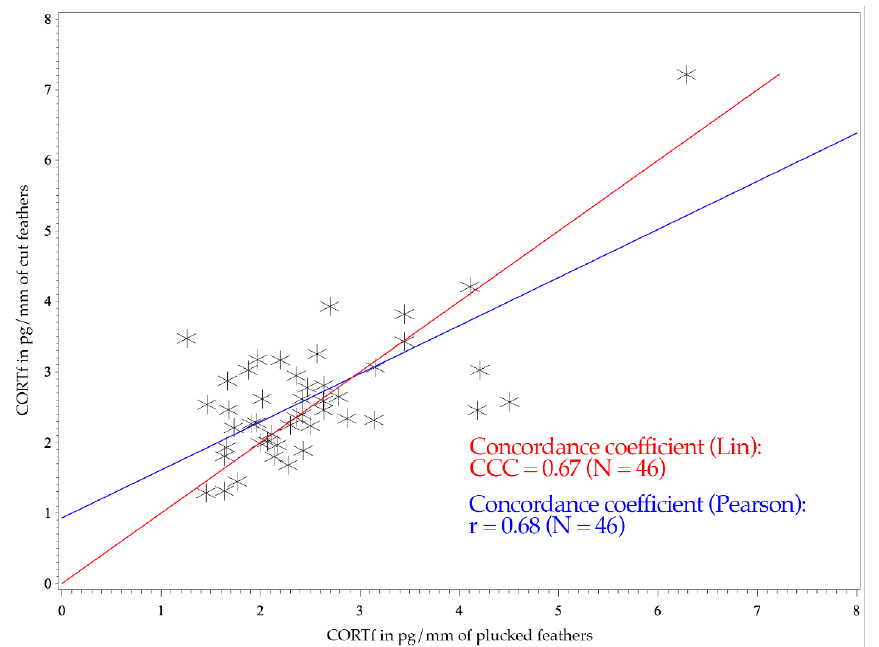
Figure 1. CCC and Pearson’s concordance coefficients of 46 Mallards ( Anas platyrhynchos ). The x - axis shows the CORTf values of plucked feathers in pg/mm, and the y -axis represents the values of cut feathers in pg/mm. The red line illustrates Lin’s concordance coefficient. Pearson’s correlation coefficient is expressed with the blue line.